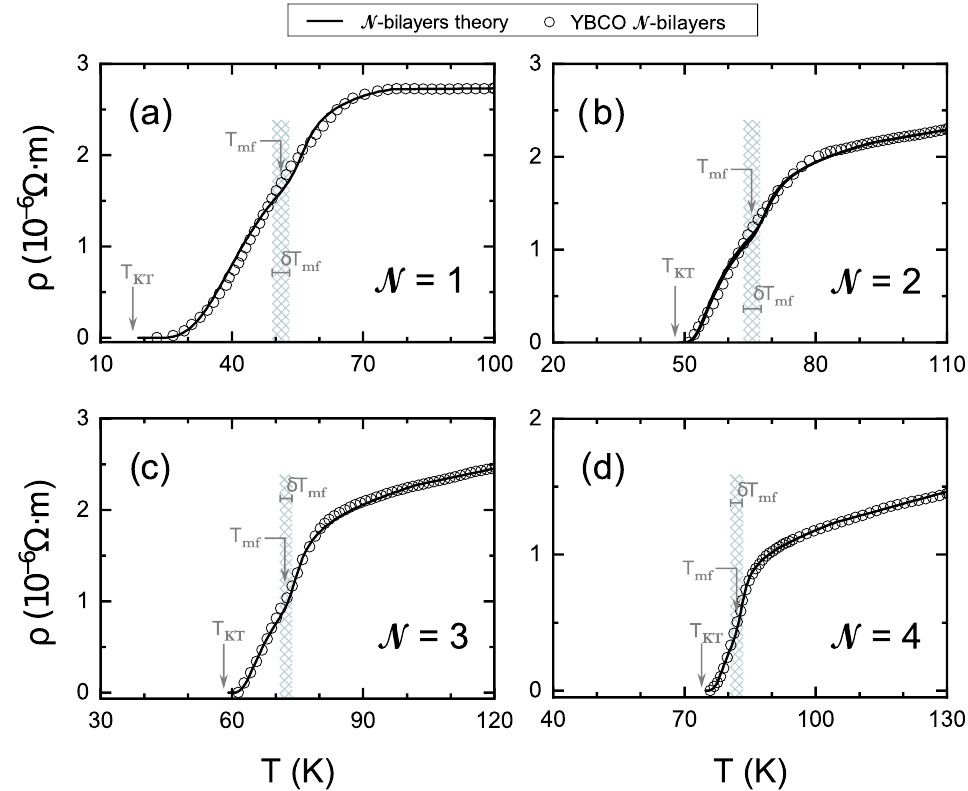
Figure 2. Same data as in Figure 1 for the electrical resistivity of samples with ( a ) N = 1, ( b ) N = 2, ( c ) N = 3 and ( d ) N = 4 unit cells of superconducting bilayers of YBa 2 Cu 3 O 7 − δ [18] (open circles) and fits to them using the equations proposed in the present paper for the critical fluctuations in few-bilayers HTSC (solid lines). The enlargement of the temperature region in which there is good agreement between data and theory is evident with respect to the previous approaches shown in Figure 1, mainly above the mean-field critical temperature T mf . The shadowed bands correspond to the temperature regions from T mf − δ T mf up to T mf + δ T mf , i.e., the ones affected by the EMA- averaging of T mf -inhomogeneities. The employed equations are described in Section 2. The general procedures for the fits, and the discussion of the results, are presented in Section 3. The numerical values of the parameters used in these comparisons are listed in Table